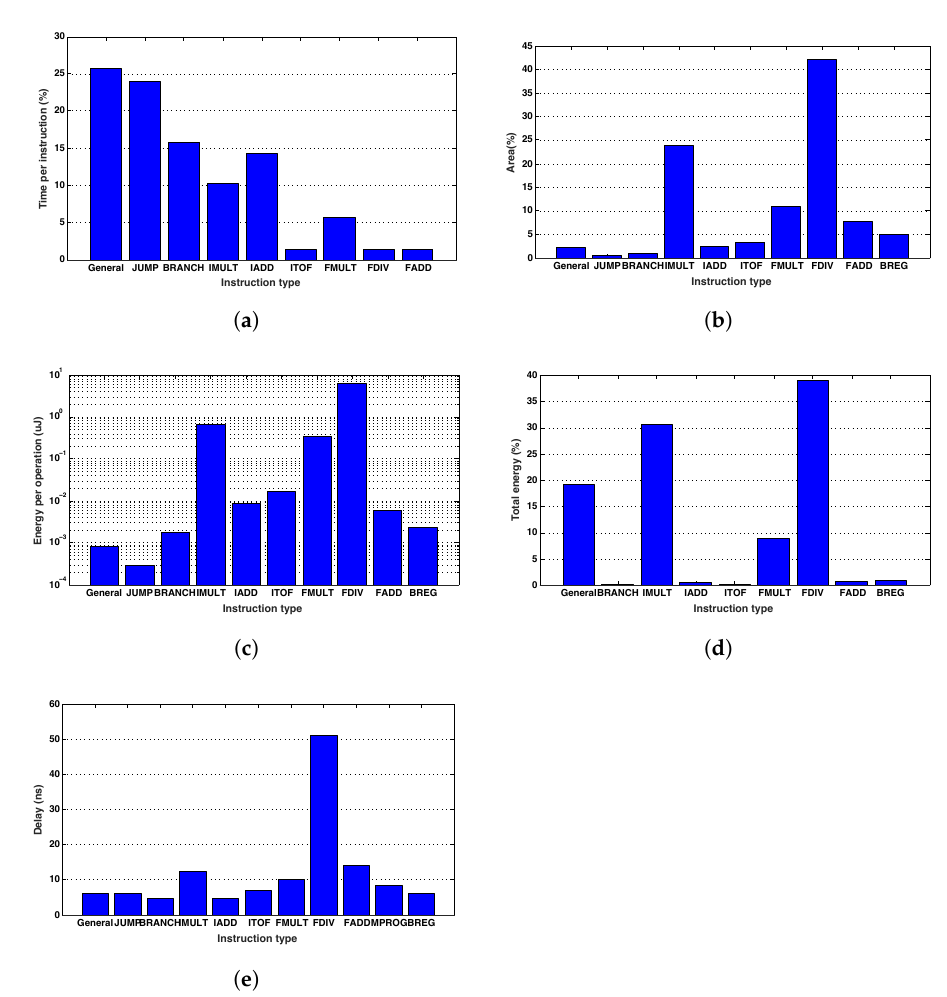
Figure 18. Estimated characteristics for the implementation of Algorithm 1 per instruction type. ( a ) Execu- tion time. ( b ) Occupied area. ( c ) Dynamic energy per operation. ( d ) Total energy. ( e ) Critical path.